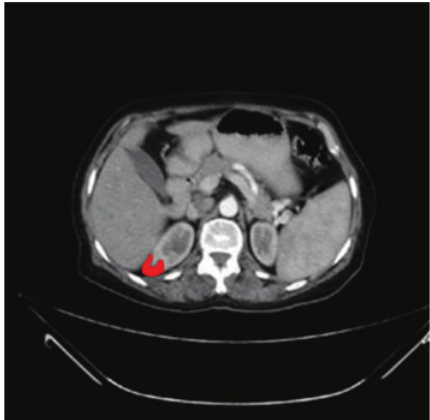
Figure 21: ROI highlighted in the original image (kidney cancer).